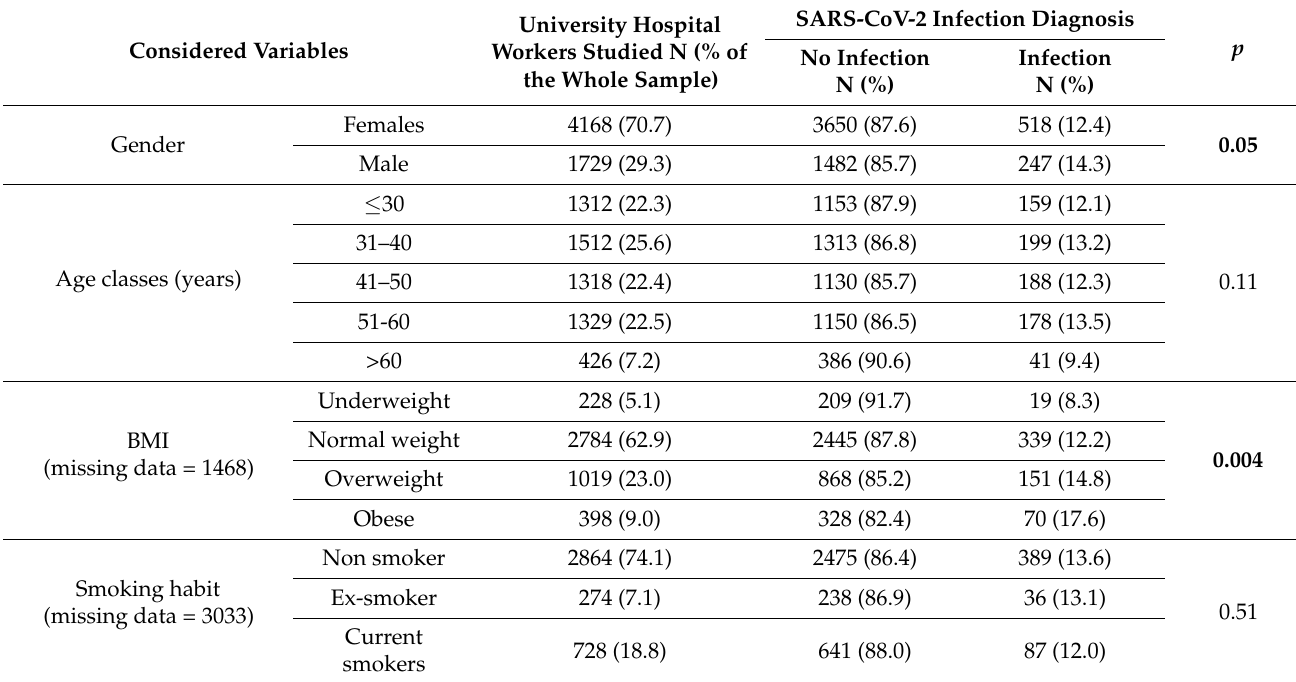
Table 1. Characteristics of the studied population with respect to COVID-19 diagnosis during the eleven-month observed period (significant results are marked in